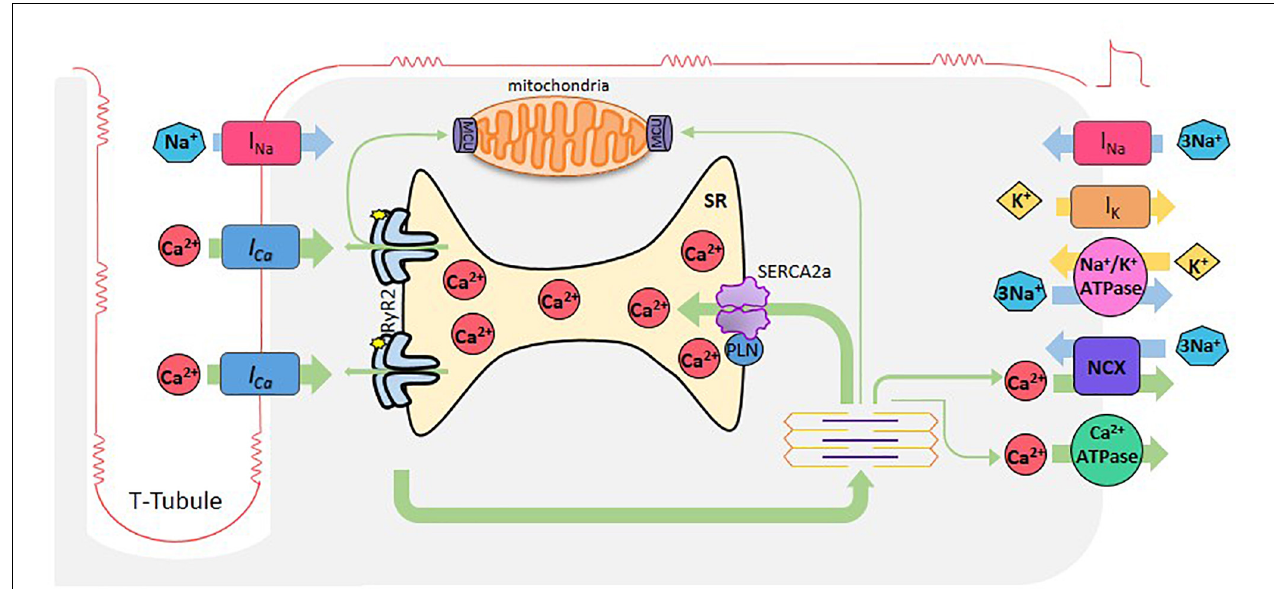
FIGURE 1 | Cardiac excitation-contraction coupling. When cardiomyocytes are reached by an AP, depolarization of the plasma membrane by Na + entry (I Na ), induces the opening of L-type Ca 2 + channels. Ca 2 + entering through these channels (Ca 2 + current, I Ca ), induces Ca 2 + release by the RyR2s (Ca 2 + -induced- Ca 2 + -release), which subsequently activates myofilaments for muscle contraction. Relaxation occurs when SR -Ca 2 + ATPase (SERCA2a) reuptakes Ca 2 + , lowering cytosolic Ca 2 + concentration in combination with Ca 2 + extrusion via the Na + - Ca 2 + exchanger (NCX) working in reverse mode and the sarcolemma Ca 2 + -ATPase. Mitochondria also participate taking and extruding Ca 2 + from the cytosol during Ca 2 + cycle. Green arrows depict Ca 2 + fluxes.